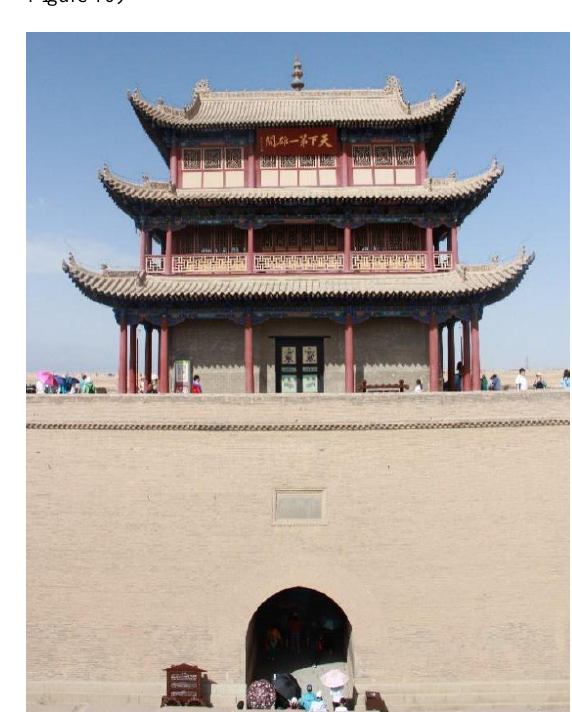
Figure 11. Guanghua Pavilion